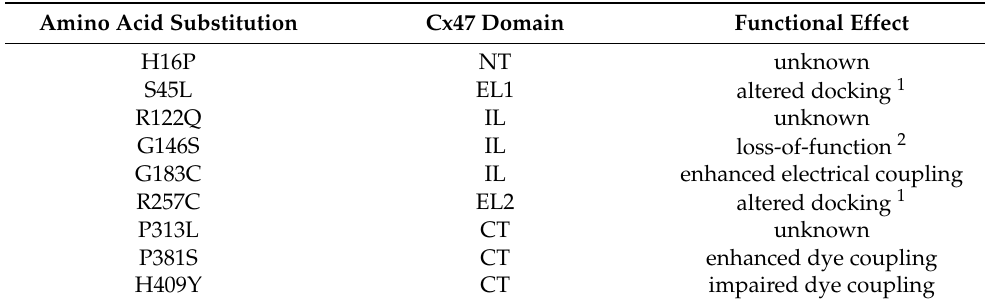
Table 1. Overview of GJC2 gene mutations found in primary and/or secondary lymphedema. Amino Acid Substitution Cx47